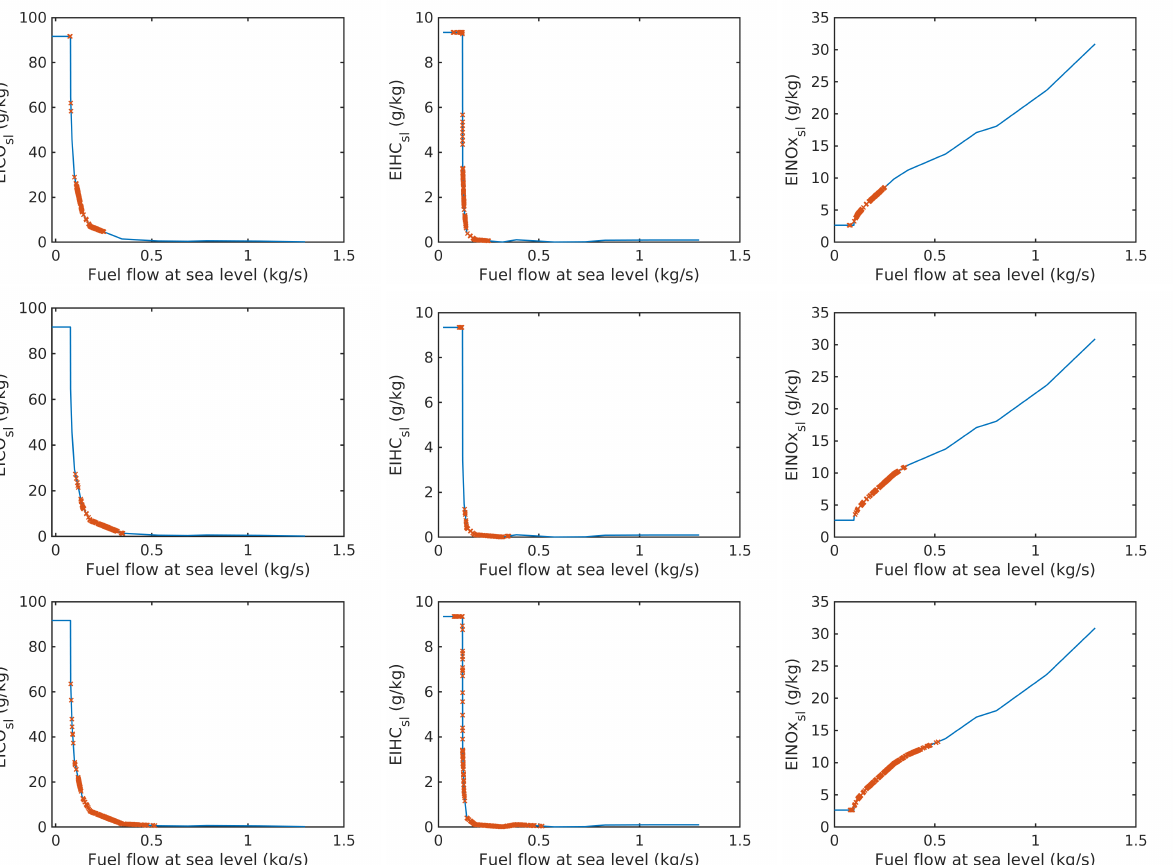
Figure 8. Emissions indices at sea level with respect to fuel flow at sea level for FDR1 ( top ), FDR2 ( middle ) and FDR4 ( bottom